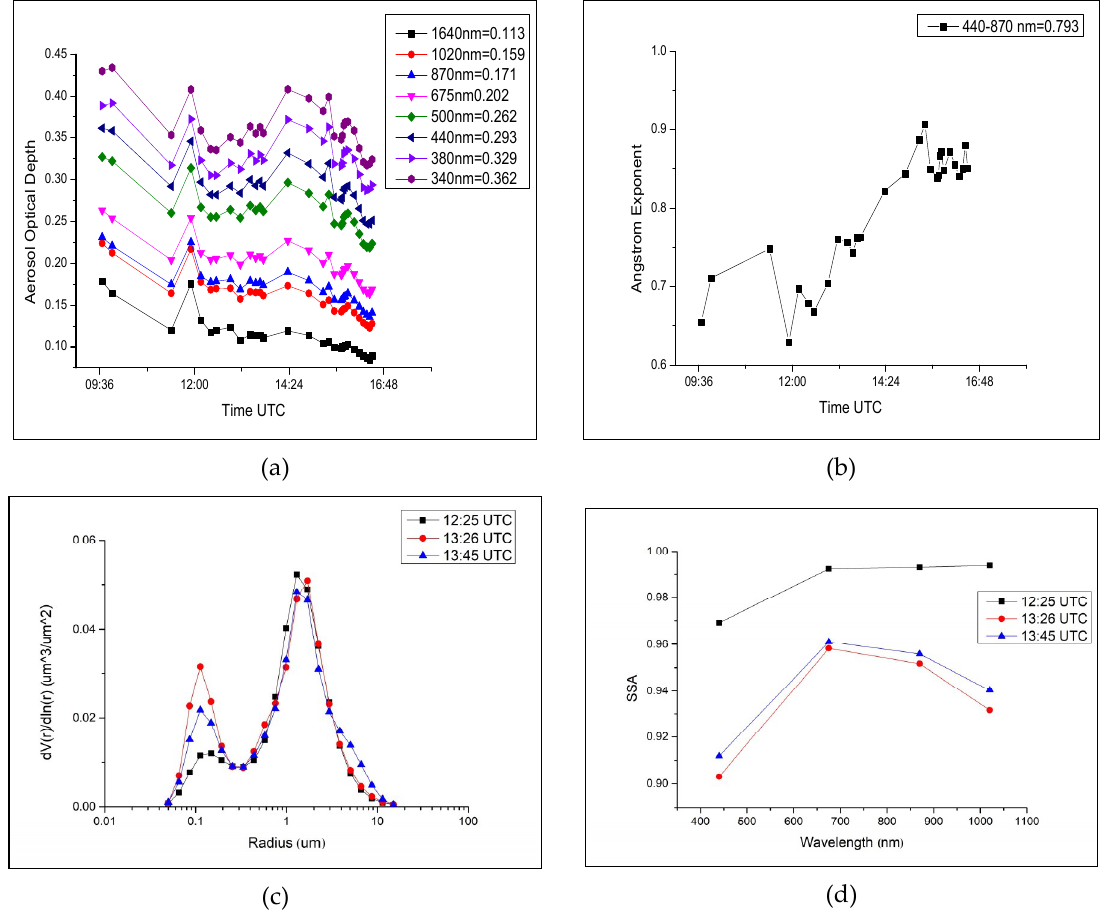
Figure 1. AERONET measurements on 24.04.2019 at CLUJ_UBB station: ( a ) aerosol optical depth (AOD), ( b ) Ångström Exponent, ( c ) Size distribution, ( d ) SSA.